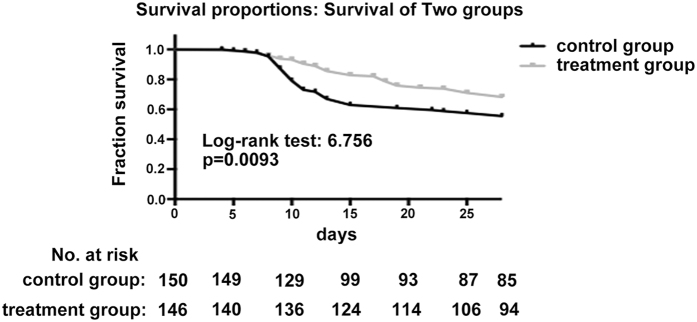
28-day survival curve between the control and intervention groups.